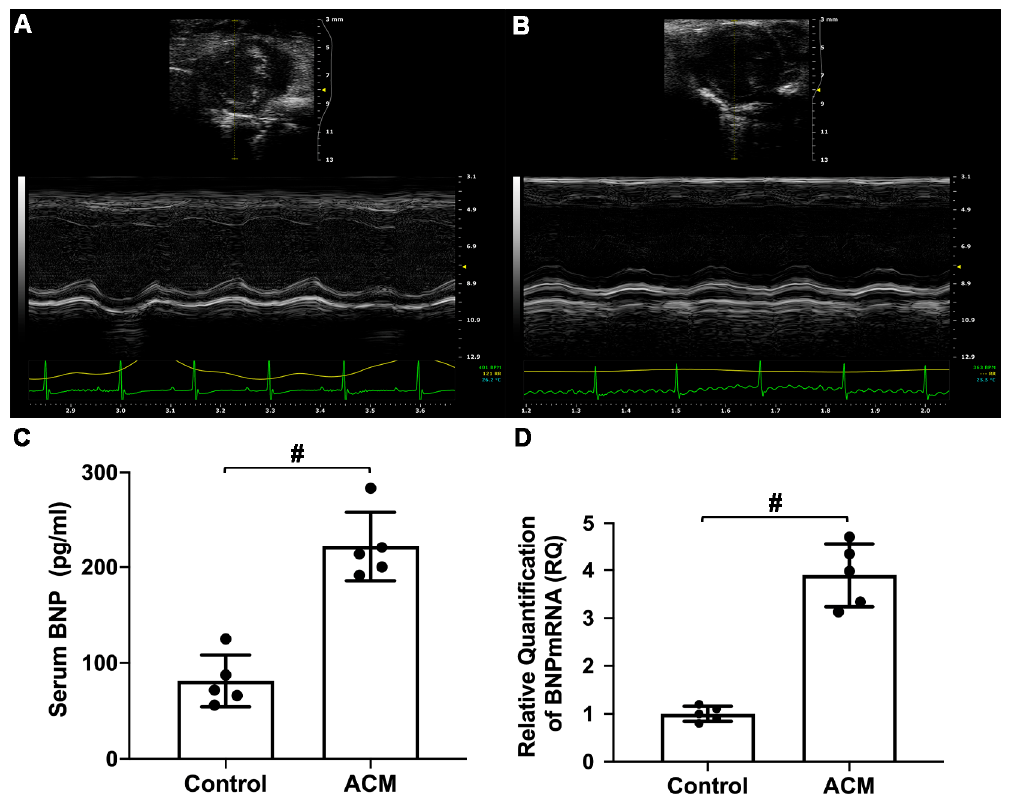
Figure 2. Assessment of cardiac function. ( A ) Echocardiography analysis of the control group; ( B ) echocardiography analysis of the ACM group; ( C ) biochemical analysis of serum brain natriuretic peptide (BNP) level; ( D ) analysis of myocardial BNP mRNA expression. # p < 0.01.